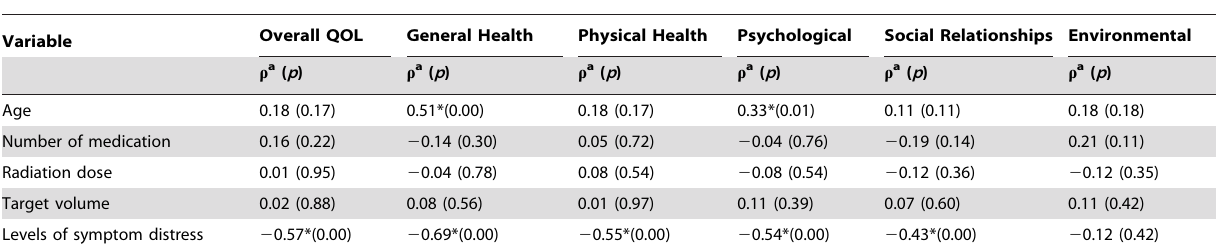
Table 3. Factors correlating with domains of quality of life (QOL) as well as overall QOL ( n= 60).